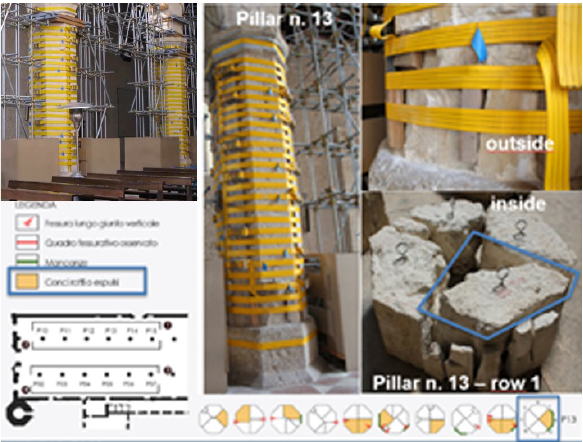
Figure 10. Pillar n. 13. A case of better ashlar stone